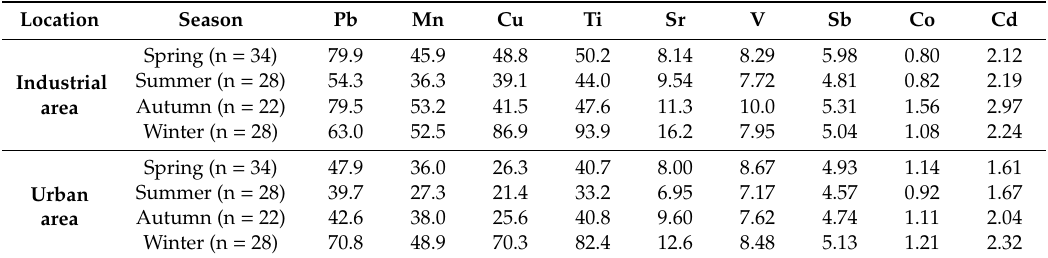
Table 3. Seasonal average concentrations (ng/m 3 ) of PM 2.5 -bound heavy metals in industrial and urban sites of Nanjing city during 2016.